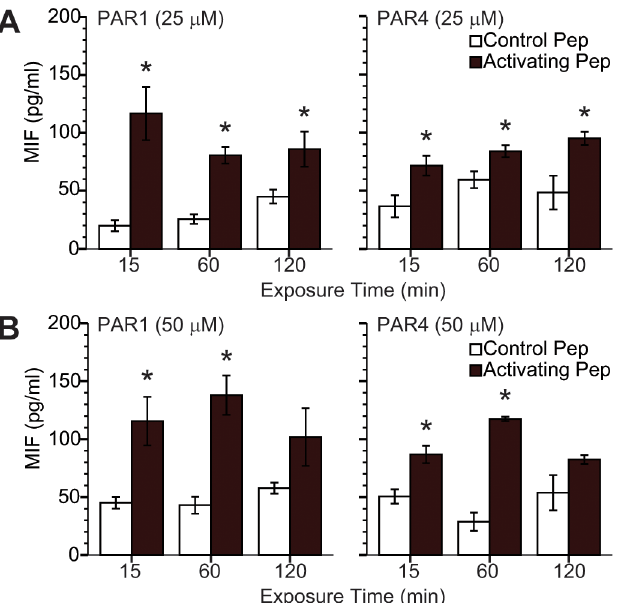
Fig 1. Human urothelial cultures release MIF after activating PAR1 or PAR4. Human benign transformed urothelial cells (UROtsa) were exposed to specific human PAR1 (TFLLR-NH2) or PAR4 (AYPGKF-NH2) activating peptides (AP), or respective scrambled peptides (control). Culture media was collected at 15, 60, and 120 minutes after AP application and assayed for MIF using a commercial ELISA kit (R&D Systems; Minneapolis, MN). Significant urothelial MIF release occurring within the first 15 minutes was observed after PAR1 or PAR4 stimulation either at 25 μ M ( A ) or 50 μ M ( B ) concentrations. * p (cid:1)